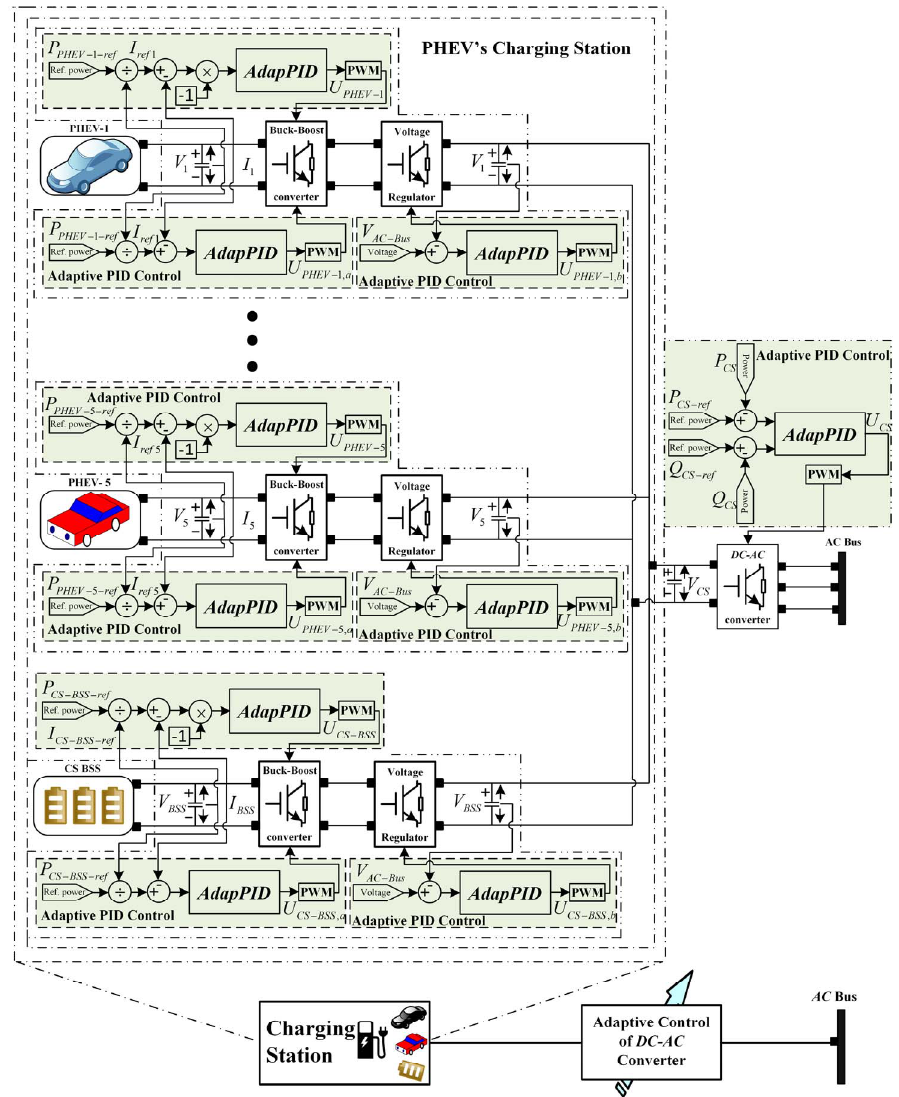
Figure 1. PHEVs charging